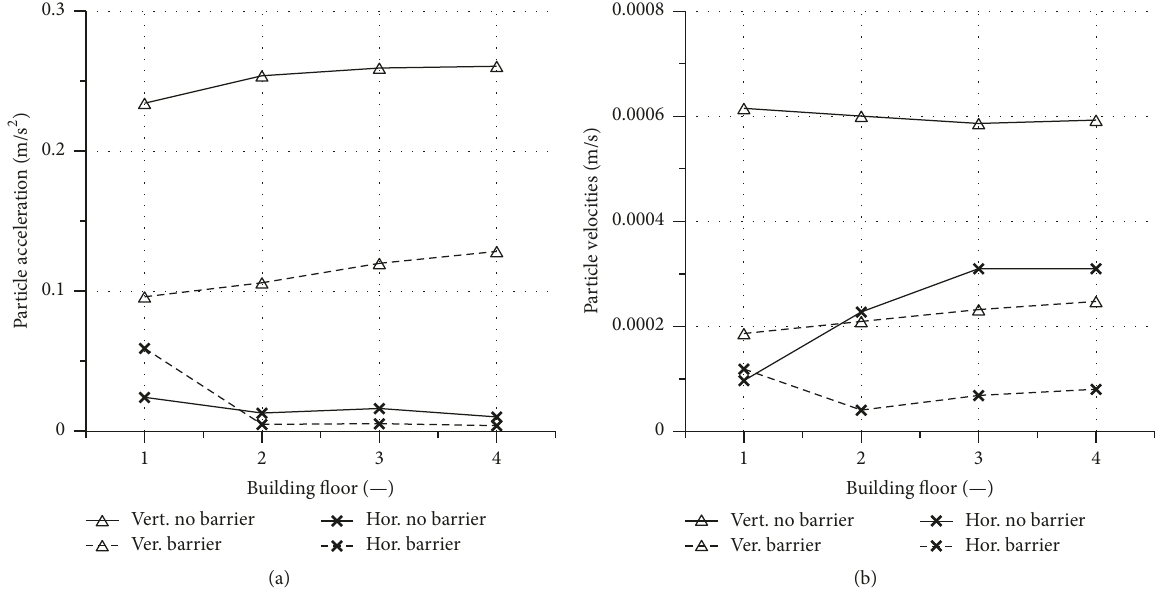
Figure 14: Maximum particle velocities and acceleration in different floors with (dashed line) and without (solid line) a wave barrier.